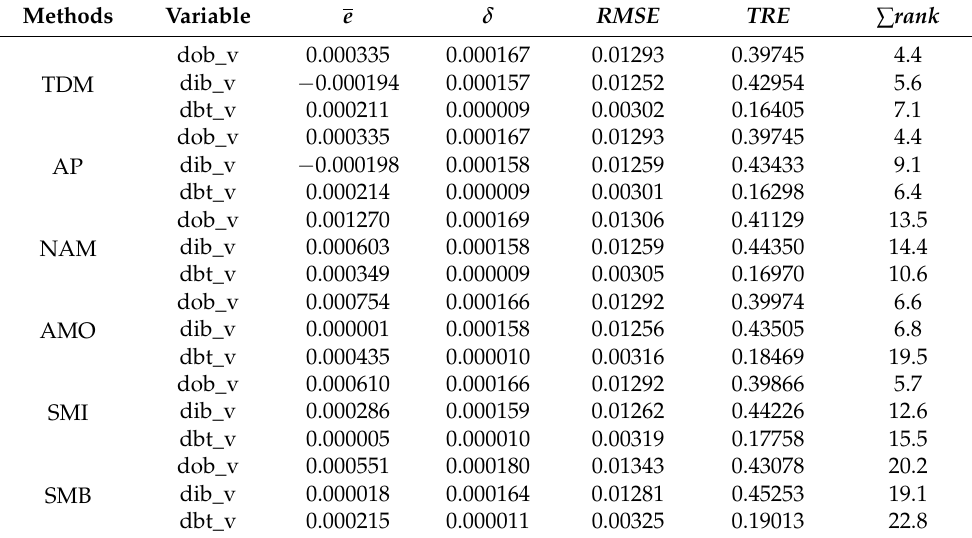
Table 6. Volume prediction for six additive